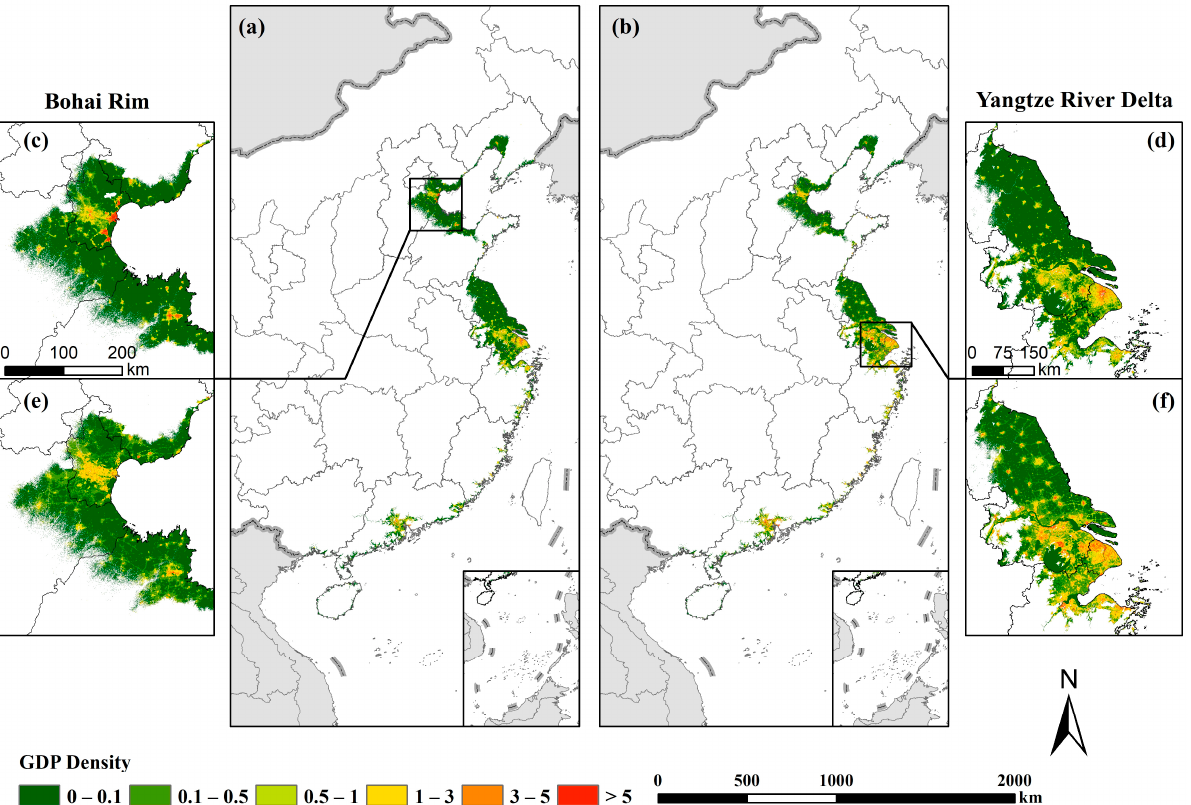
Figure 6. A 100 m gridded GDP 2 map of China’s LECZ in 2010 ( a , c , d ) and 2019 ( b , e , f ) (unit: million CNY/ha).